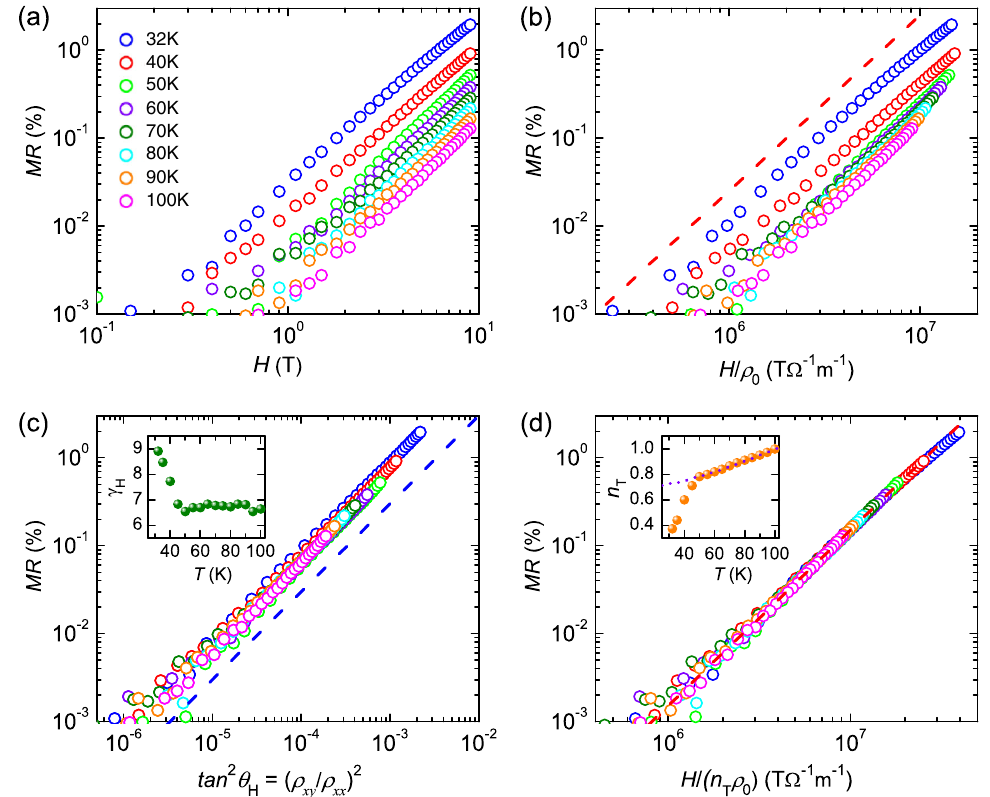
Þ ¼ 0 . 25 (sample PL). (a) MR ð H Þ curves at FIG. 6. Scaling behavior of the magnetoresistance of a BaFe 2 ð As 1 − P 2 crystal with x x x various temperatures. (b) Scaling according to the Kohler ’ s rule. The red line represents MR ∼ ð H= ρ 0 Þ 2 . (c) Scaling according to Eq. (3). ¼ 3 , demonstrating the validity of Eq. (3). The value of γ tan 2 θ with γ for each The dashed straight blue line is MR ¼ γ H H H H temperature is presented in the inset. (d) Scaling according to the extended Kohler ’ s rule Eq. (1). The red line represents ρ Þ(cid:2) 2 . The inset shows the derived n , where the dotted purple line describes a possible pseudogap temperature MR ∼ ½ H= ð n 0 T T ¼ n þ α Te − Δ =k B T with n ¼ 0 . 7 , α ¼ 5 . 4 × 10 − 3 , and Δ ¼ 5 . 18 meV (or Δ =k ¼ 60 K). The same colored open behavior of n 0 0 T B symbols are used in all